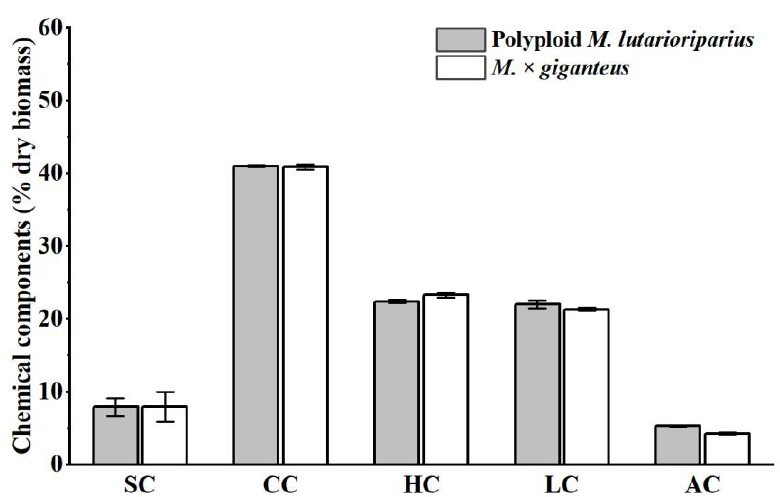
Figure 2. Chemical components of lignocellulosic biomass in polyploid Miscanthus lutarioriparius and Miscanthus × giganteus . Soluble content (SC), Cellulose content (CC), Hemicellulose content (HC), Lignin content (LC), Ash content (AC). Vertical bar are standard deviation ( n = 2).